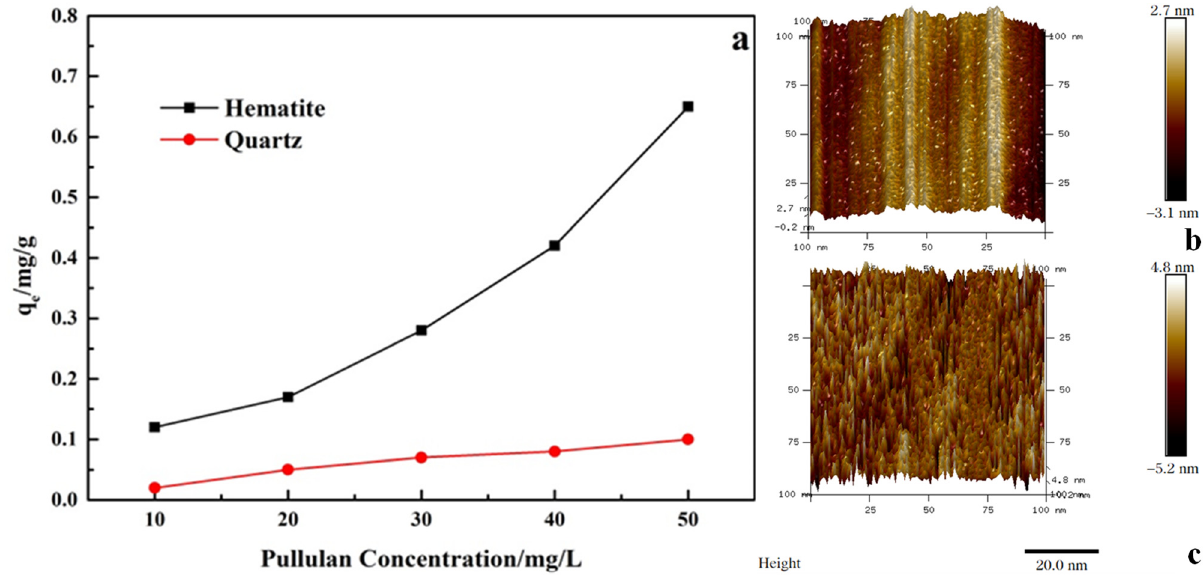
Figure 7. Adsorption capacity of pullulan on the minerals ( a ) and adsorption morphology of pul- lulan on the hematite surface ( b , c